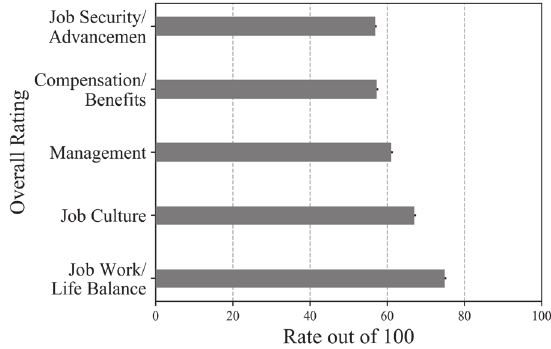
Fig. 3. Aggregated Overall